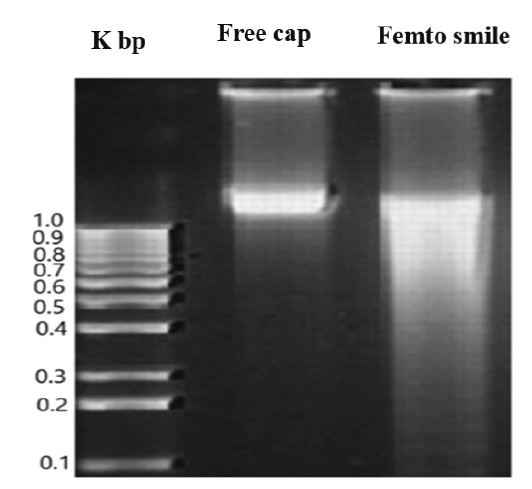
Figure 3. 0.1% Agarose gel electrophoresis for analysis of DNA fragmentation showed a well-defined band for the free cap and an undefined band for the Femto SMILE group. The first band represents the DNA markers. Kbp, kilo base pair.